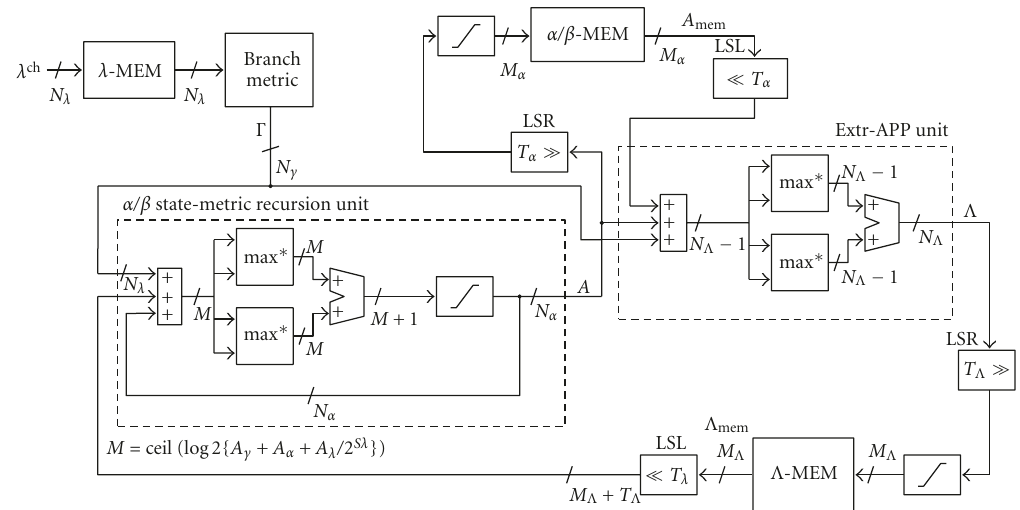
Figure 10: Fixed-point model of the SISO engine in a turbo